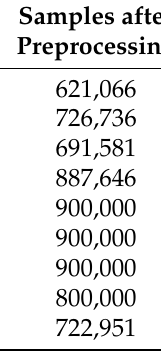
Table 1. The sampling method and size of the data samples for each latitude